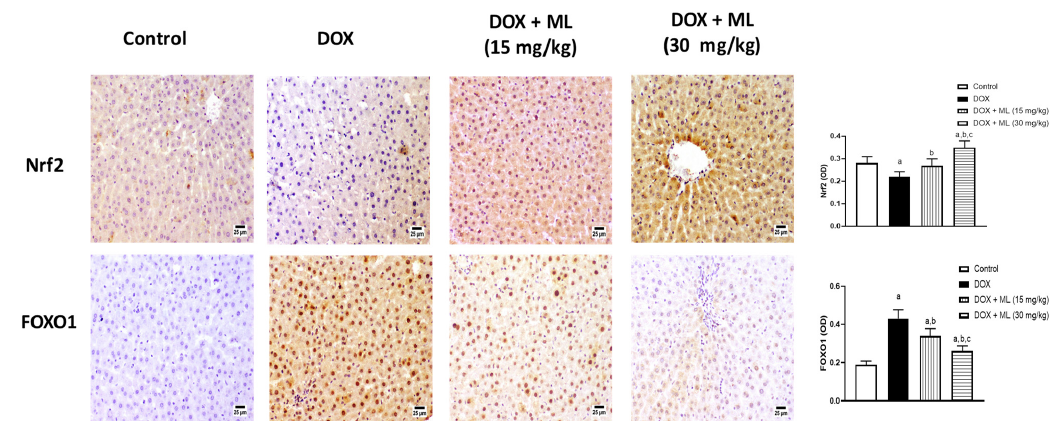
Figure 5. Effect of ML on expression of Nrf2 and FOXO1. Immunohistochemical photomicrographs of liver sections demonstrating the effect of ML on DOX-induced alteration in Nrf2 and FOXO1. Data presented in bar charts are Mean of optical densities ± SD ( n = 6). a, b or c: Statistically different from Control, DOX or DOX + ML (15 mg/kg), respectively at p < 0.05.